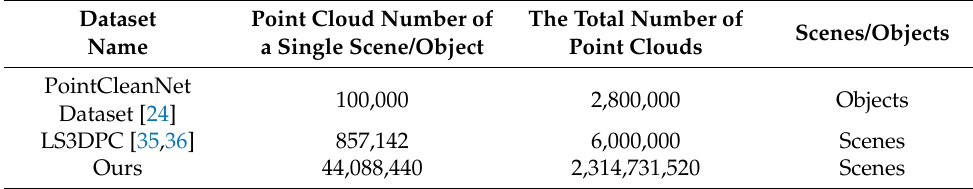
Table 3. Point numbers of point clouds.